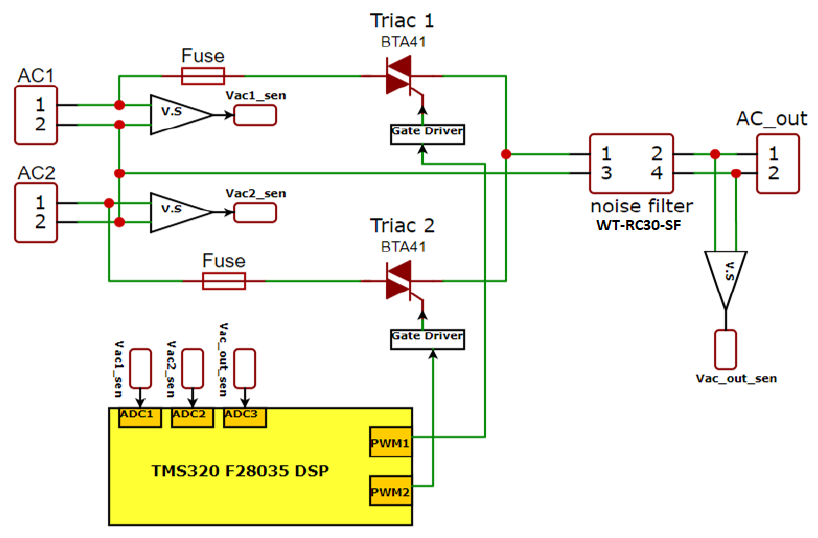
Figure 10. Schematic circuit of the proposed SSTS board for experimental testing (where V.S represents the proposed online voltage sensing circuit presented in Figure 4).